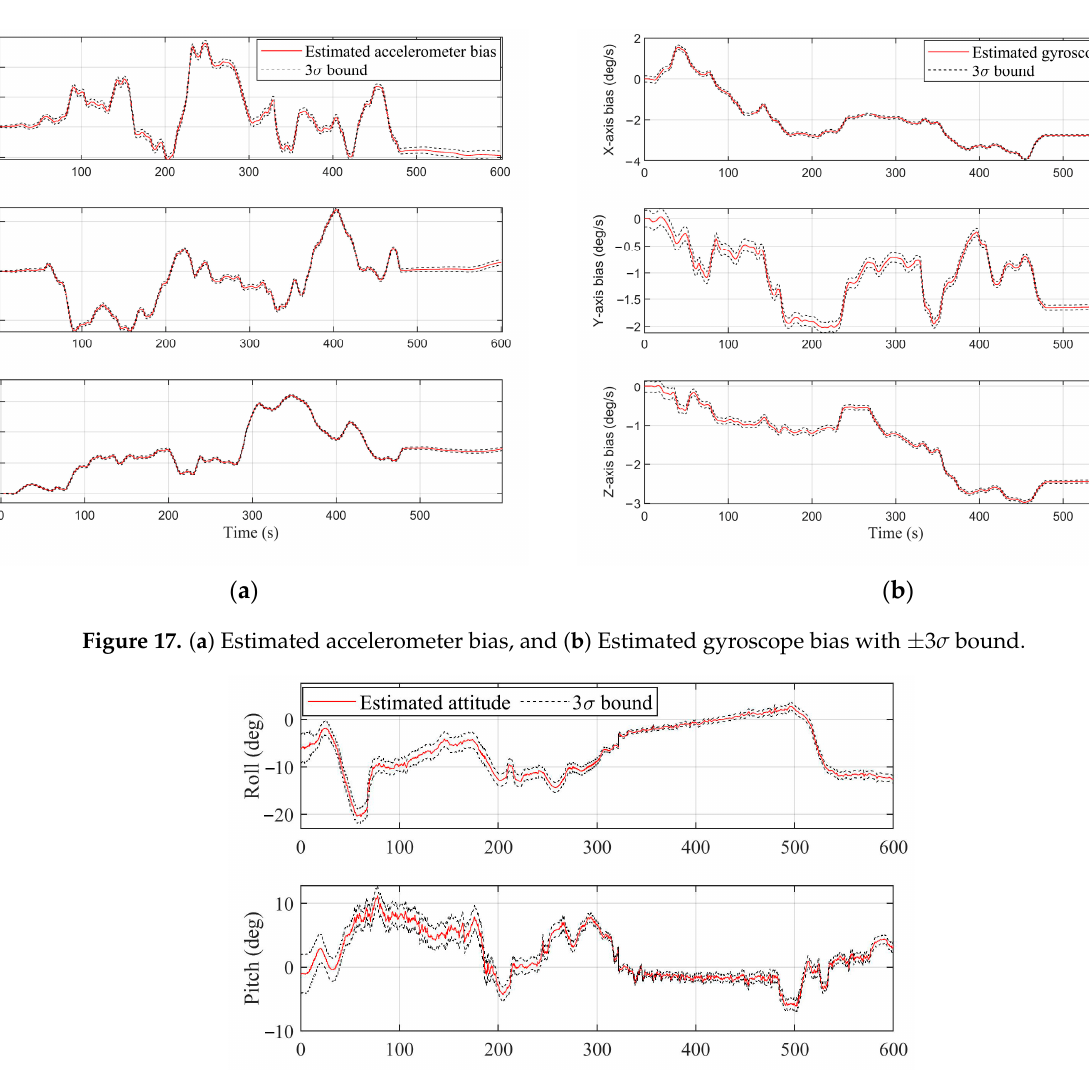
19 of 23 Table 2 shows the root mean square error (RMSE) of the proposed method in different time slots. The goal was to measure the stability and the resiliency of the system in longer terms. As mentioned before, the GNSS was blocked after 5 min and 30 s from the start point of the experiment. The RMSE in the first 1.5 min of the experiment was 35.6654 m, and after 1 min it reached 56.1978 m. Then, it culminated at 372.1078 m in the next minutes. The RMSE of the entire trajectory for 4.5 min of the experiment was 196.7429 m. Figure 17 illustrates the estimated bias of the IMU, and Figure 18 shows the estimated orientation of the aircraft. ( a ) ( b ) Figure 16. The North ( a ) and East ( b ) position errors of the aircraft before and after blocking the GNSS compared with the error of the Doppler positioning method. Table 2. RMSE of the alignment method for different time slots from the start point compared with the error of the Doppler positioning method.